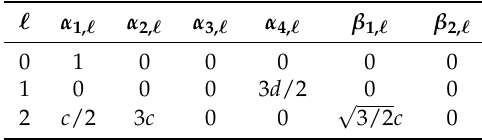
Table 1. Expansion Coefficients for Rayleigh